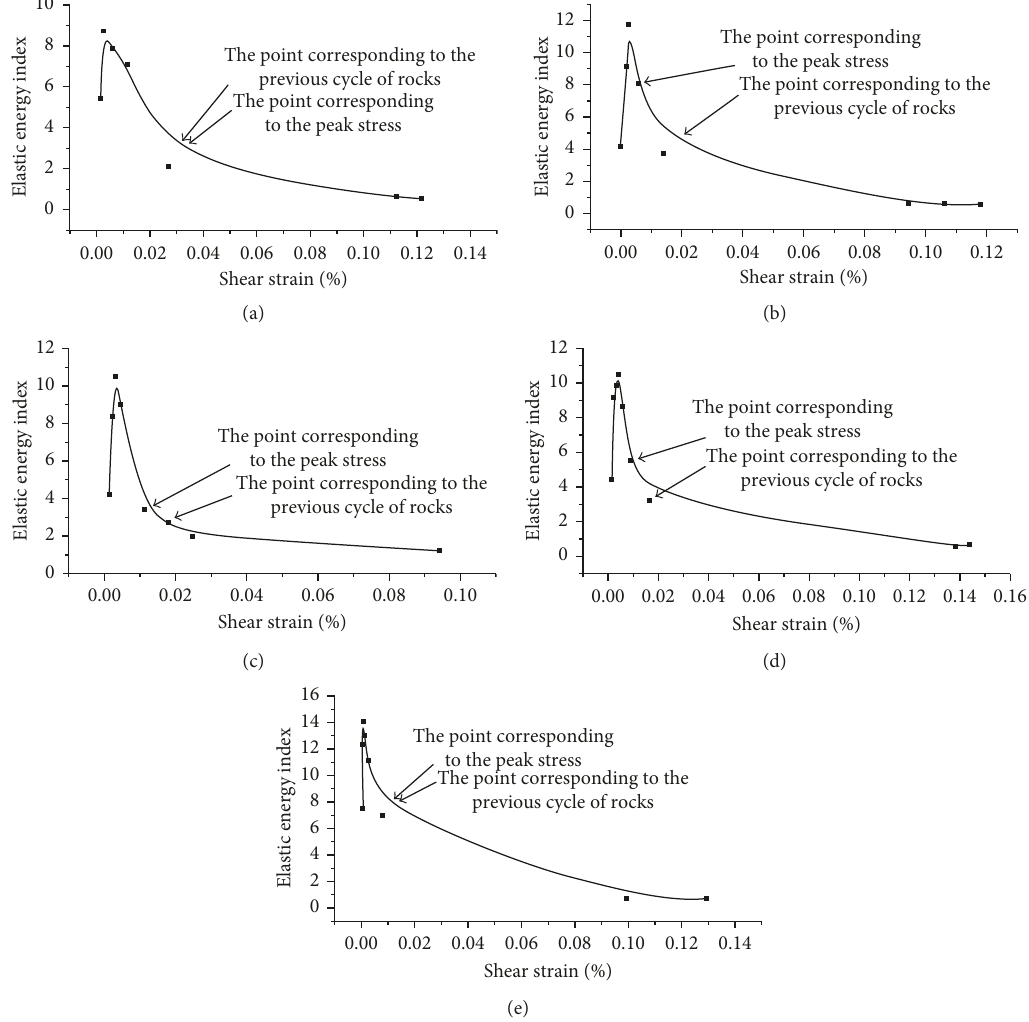
Figure 8: Fitting curve of plastic shear strain and elastic energy index under different confining pressures: (a) 1MPa; (b) 5MPa; (c) 10MPa; (d) 20MPa; (e)